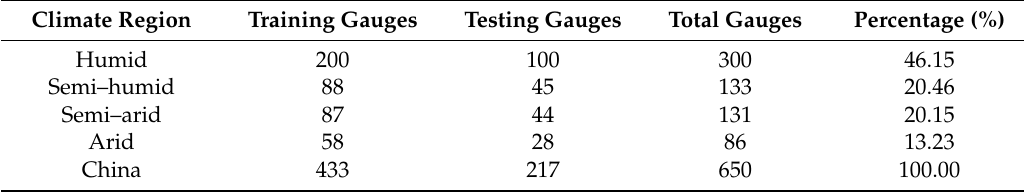
Table 1. Number of rain gauges in each climate region and each region’s percentage of total number of rain gauge stations across